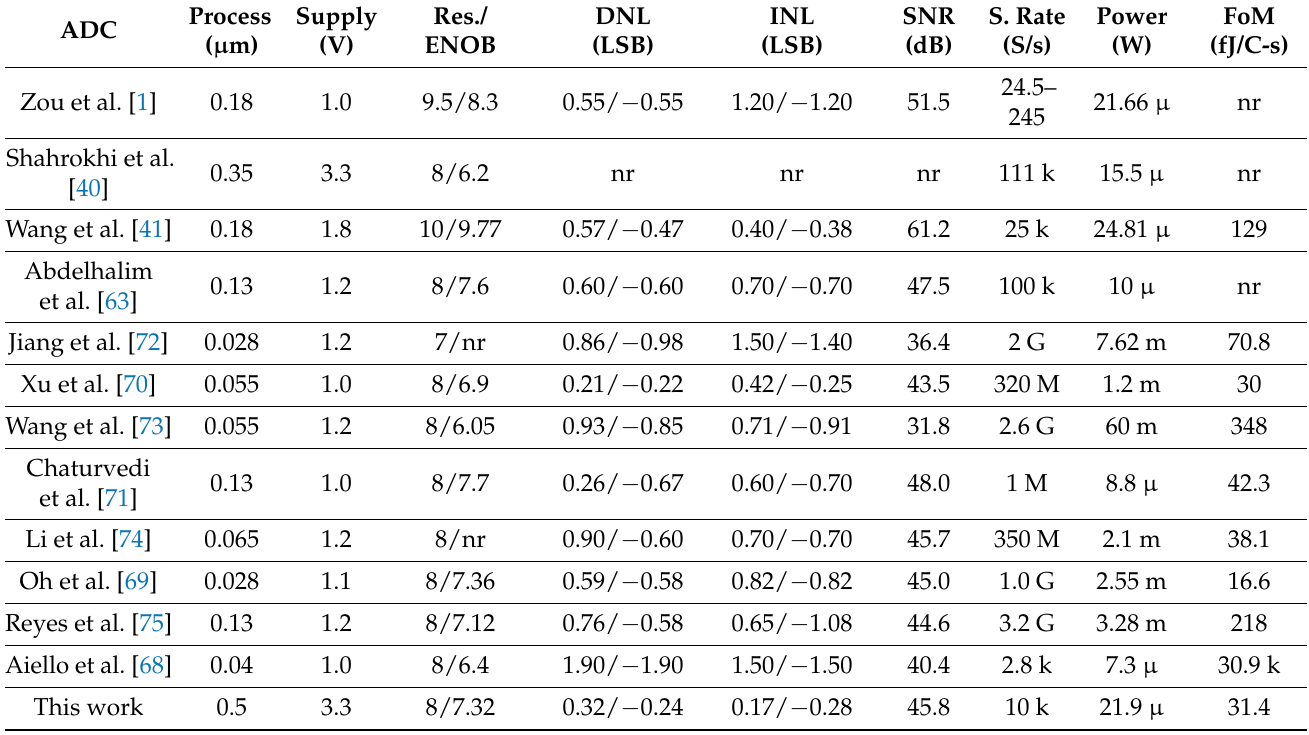
Table 3. ADC performance